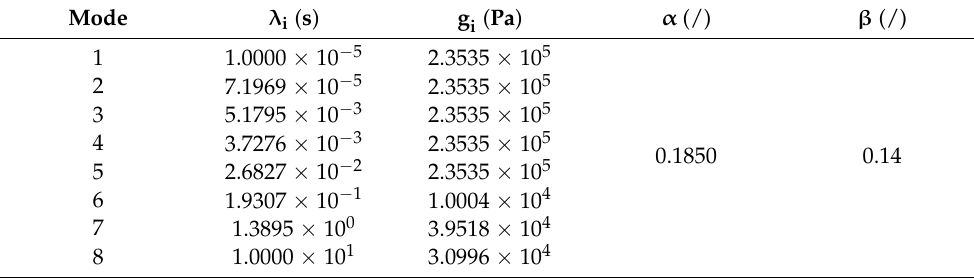
Table A2. K-BKZ/Wagner model parameters (fit 2) for gum NBR at the reference temperature of